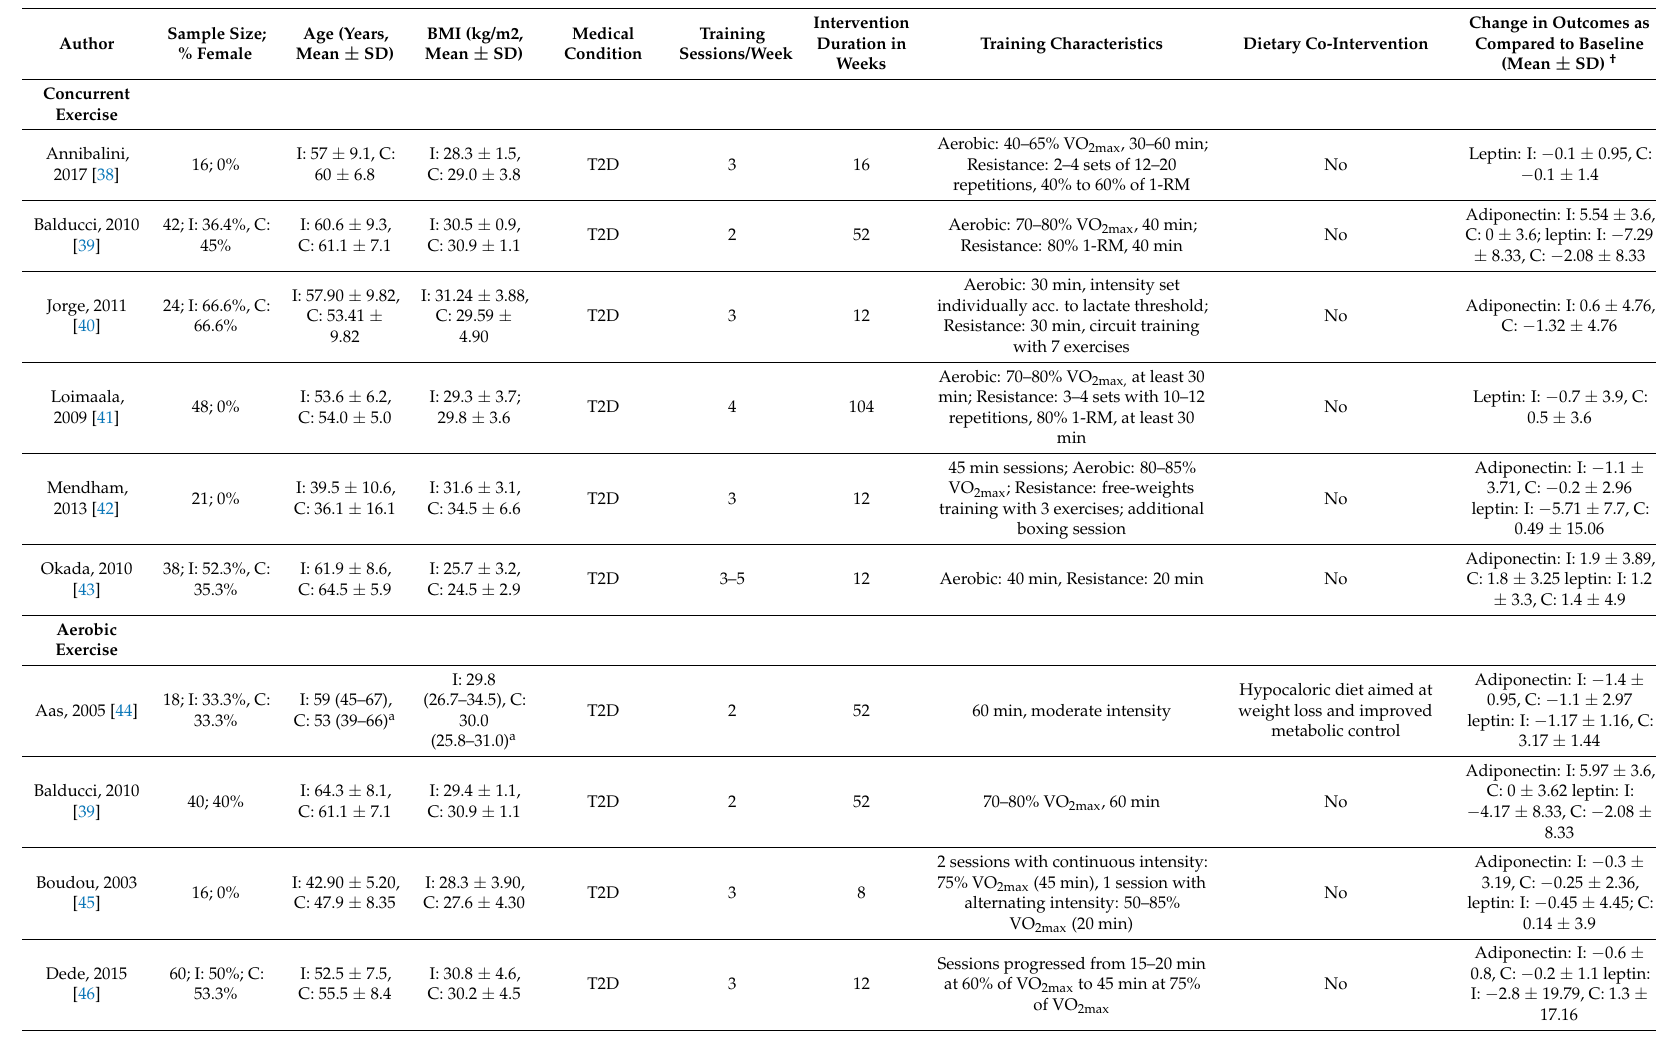
Table 1. Study characteristics. Values expressed are mean ± standard deviation (SD), unless indicated